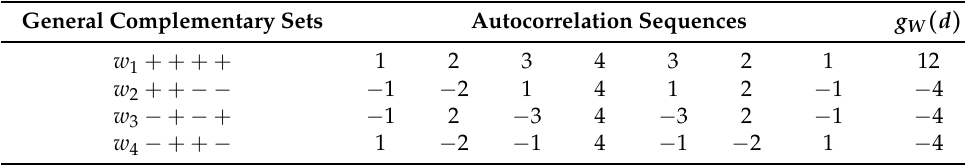
Table A3. Example for the illustration of Property 2 ( L = 4).